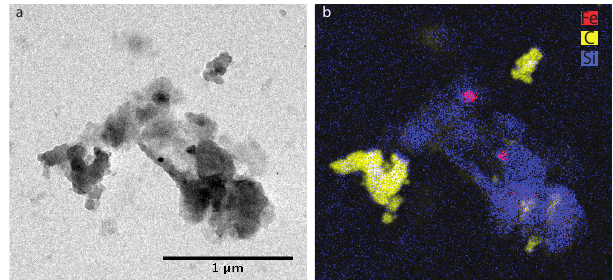
Figure 6. Examples of particles concentrated from a Law Dome, Antarctica ice core dated to 1930CE. (a) TEM image and (b) EFTEM map of a complex aggregate particle where red is iron, blue is silicon, and yellow is carbon.